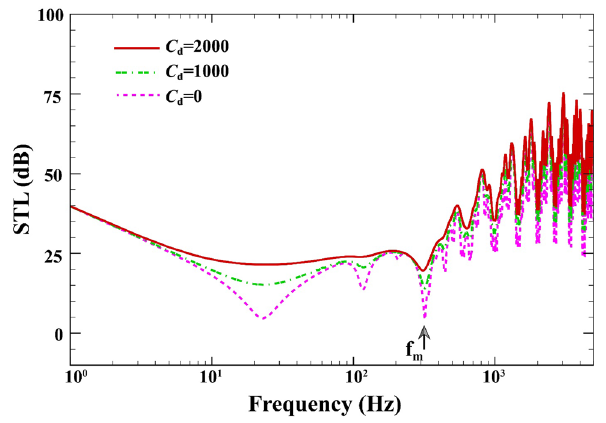
Figure 8. STL of double-walled sandwich composite MEE plate against the viscoelastic medium’s damping coefficient.